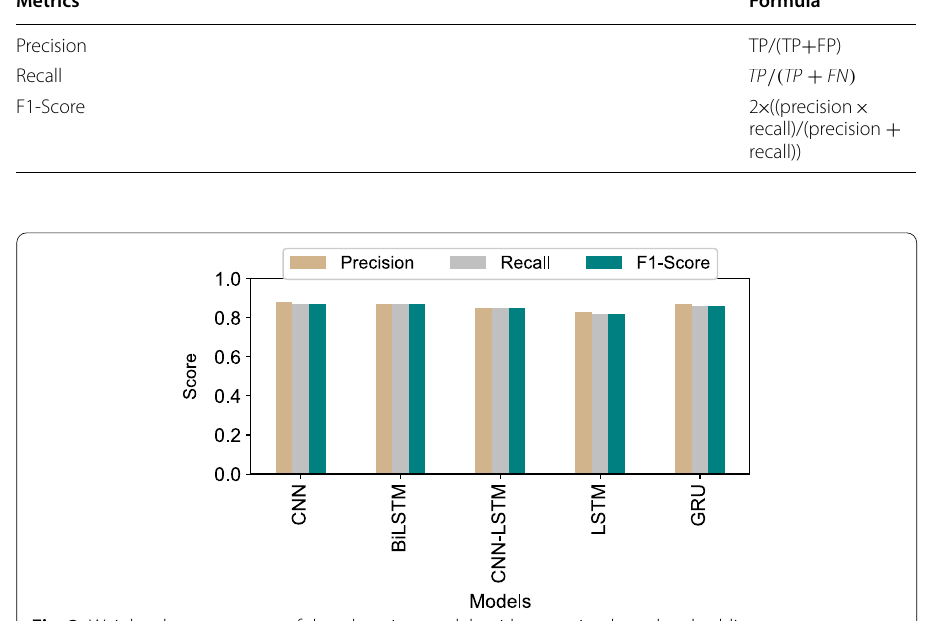
Fig. 2 Weighted average score of deep learning models with pre-trained word